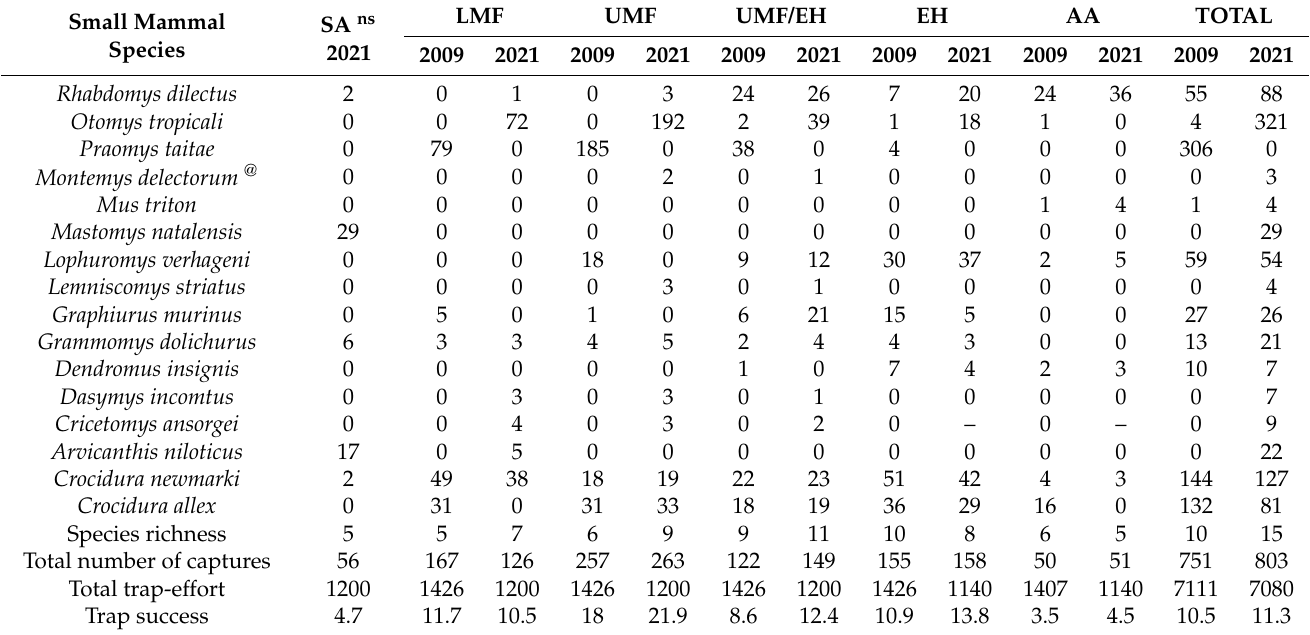
Table A1. Individual captured small mammal species and sampling efforts in the 2009 and 2021 studies on Mount Meru.